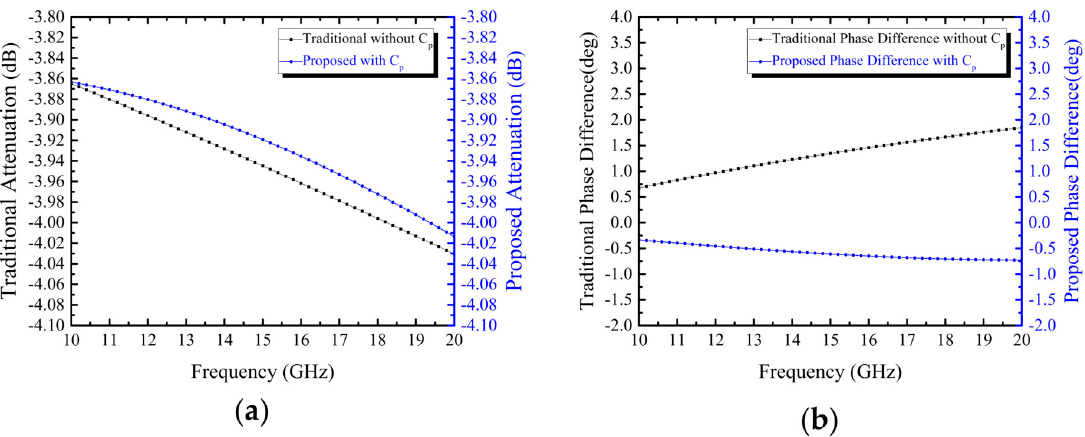
Figure 5. ( a ) The simulation attenuation results with traditional T-type and proposed C p T-type topology in 4 dB attenuation cell; ( b ) the simulation phase difference results with traditional T-type and proposed C p T-type topology in 4 dB attenuation cell.